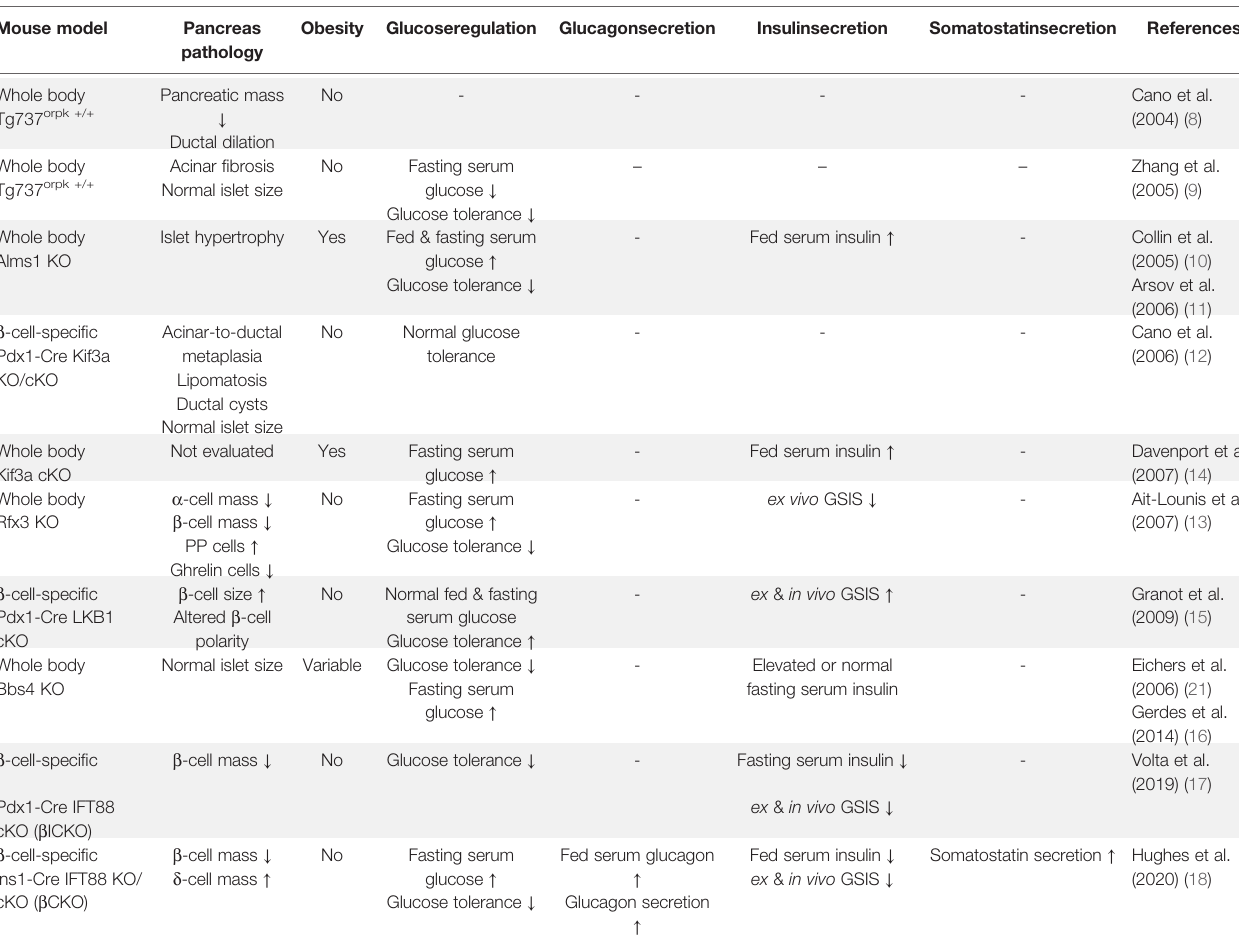
TABLE 1 | Mouse models used in studying pancreatic islet cilia